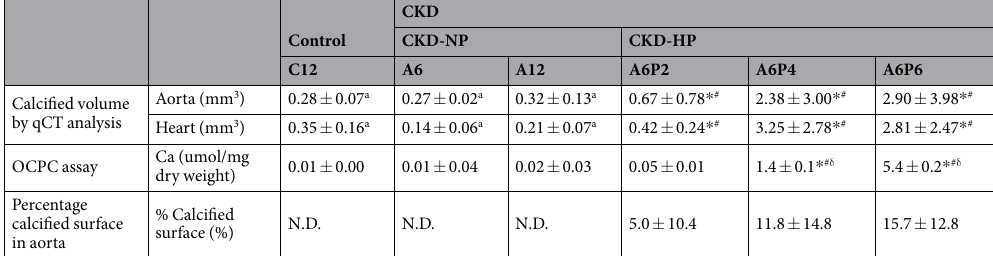
Table 2. Quantification of MAC by multiple analytical methods. MAC, medial arterial calcification; qCT, quantitative computed tomography; OCPC, o-cresolphthalein complexone; Ca, calcium. The data are represented as the means ± SEM (n = 5). N.D.: not detected. a Calcified volume in control and CKD-NP groups are considered to be false positive by mechanical artifacts. * P < 0.05 vs C12, # P < 0.01 vs A6, δ P < 0.05 vs A12 by non-repeated measures